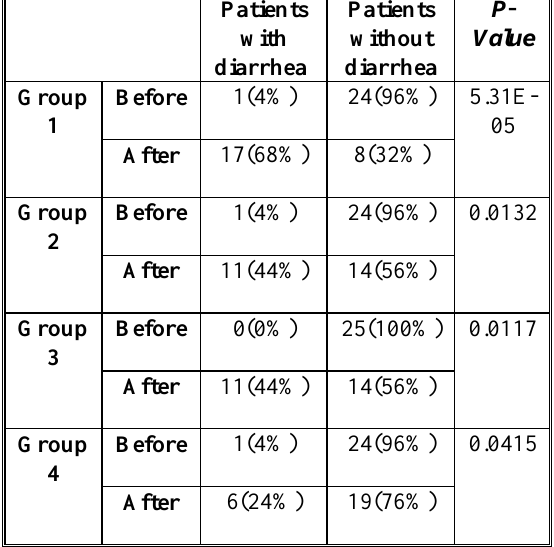
Table 1. The presence of diarrhea in patients before and after a specific medication protocol.